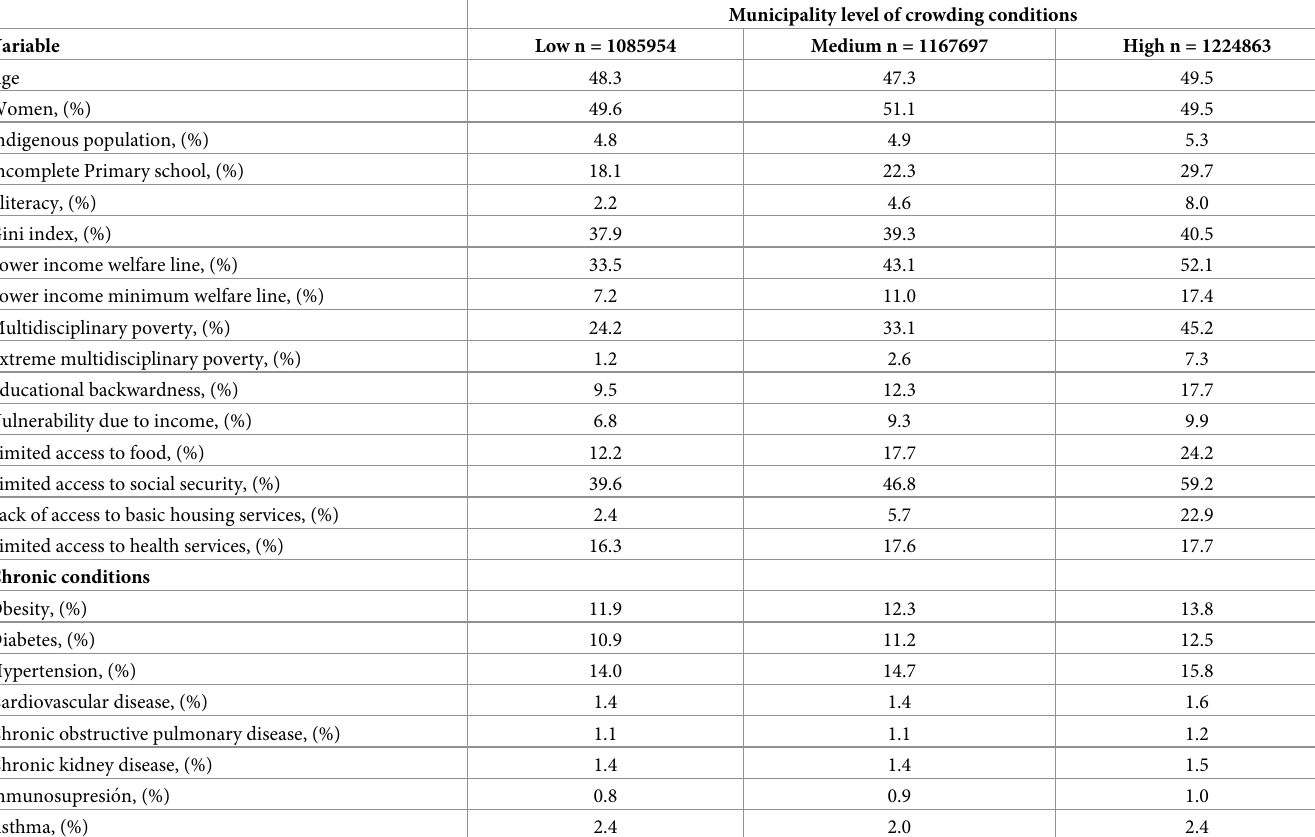
Table 1. Sociodemographic characteristics and chronic conditions of patients with COVID-19 according to the municipality level of crowding conditions. Municipality level of crowding